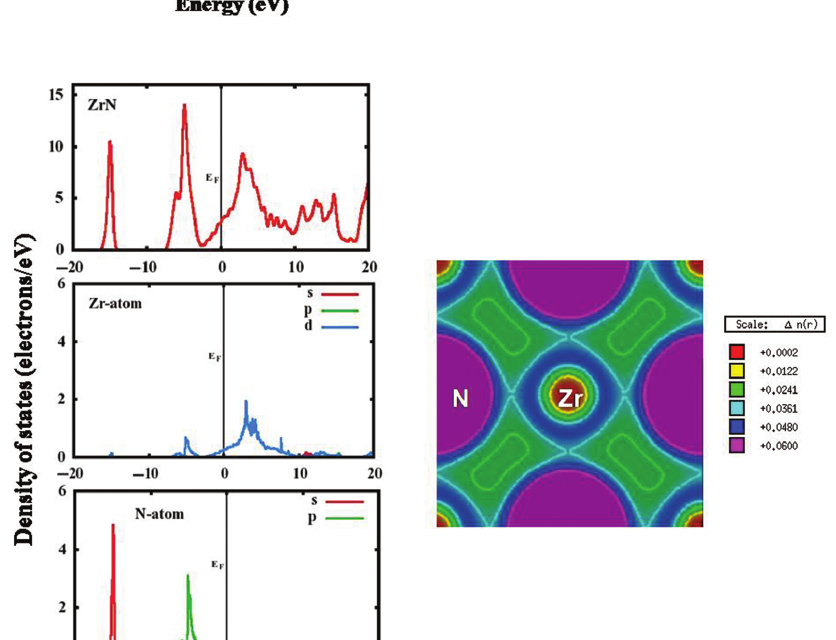
Figure 3: Electronic DOS and 2D charge density of